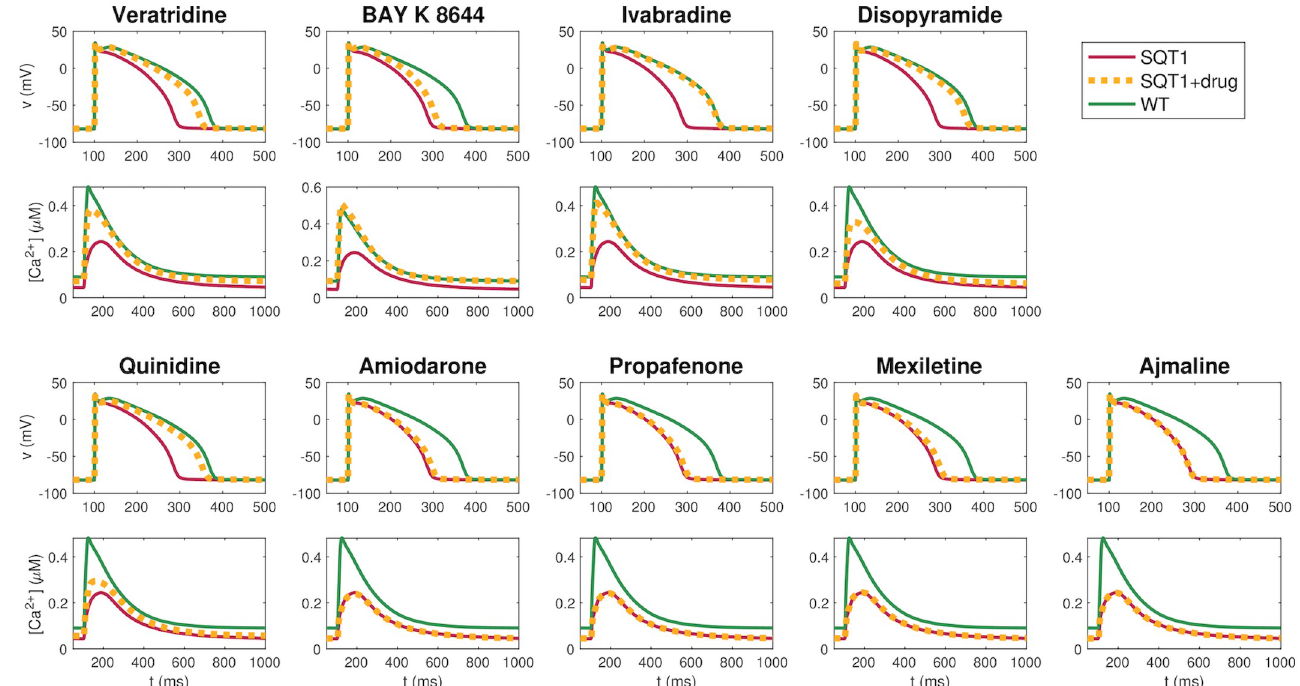
Fig 5. AP and Ca 2+ transient for adult human ventricular myocytes in the wild type case, in the SQT1 case, and in the SQT1 case with the optimal dose of each of the drugs of Table 1 applied. The selected drugs are ordered from the smallest to the highest obtained cost function values. The applied doses are specified in Table 3. Data used in this figure can be found in S1 Data.